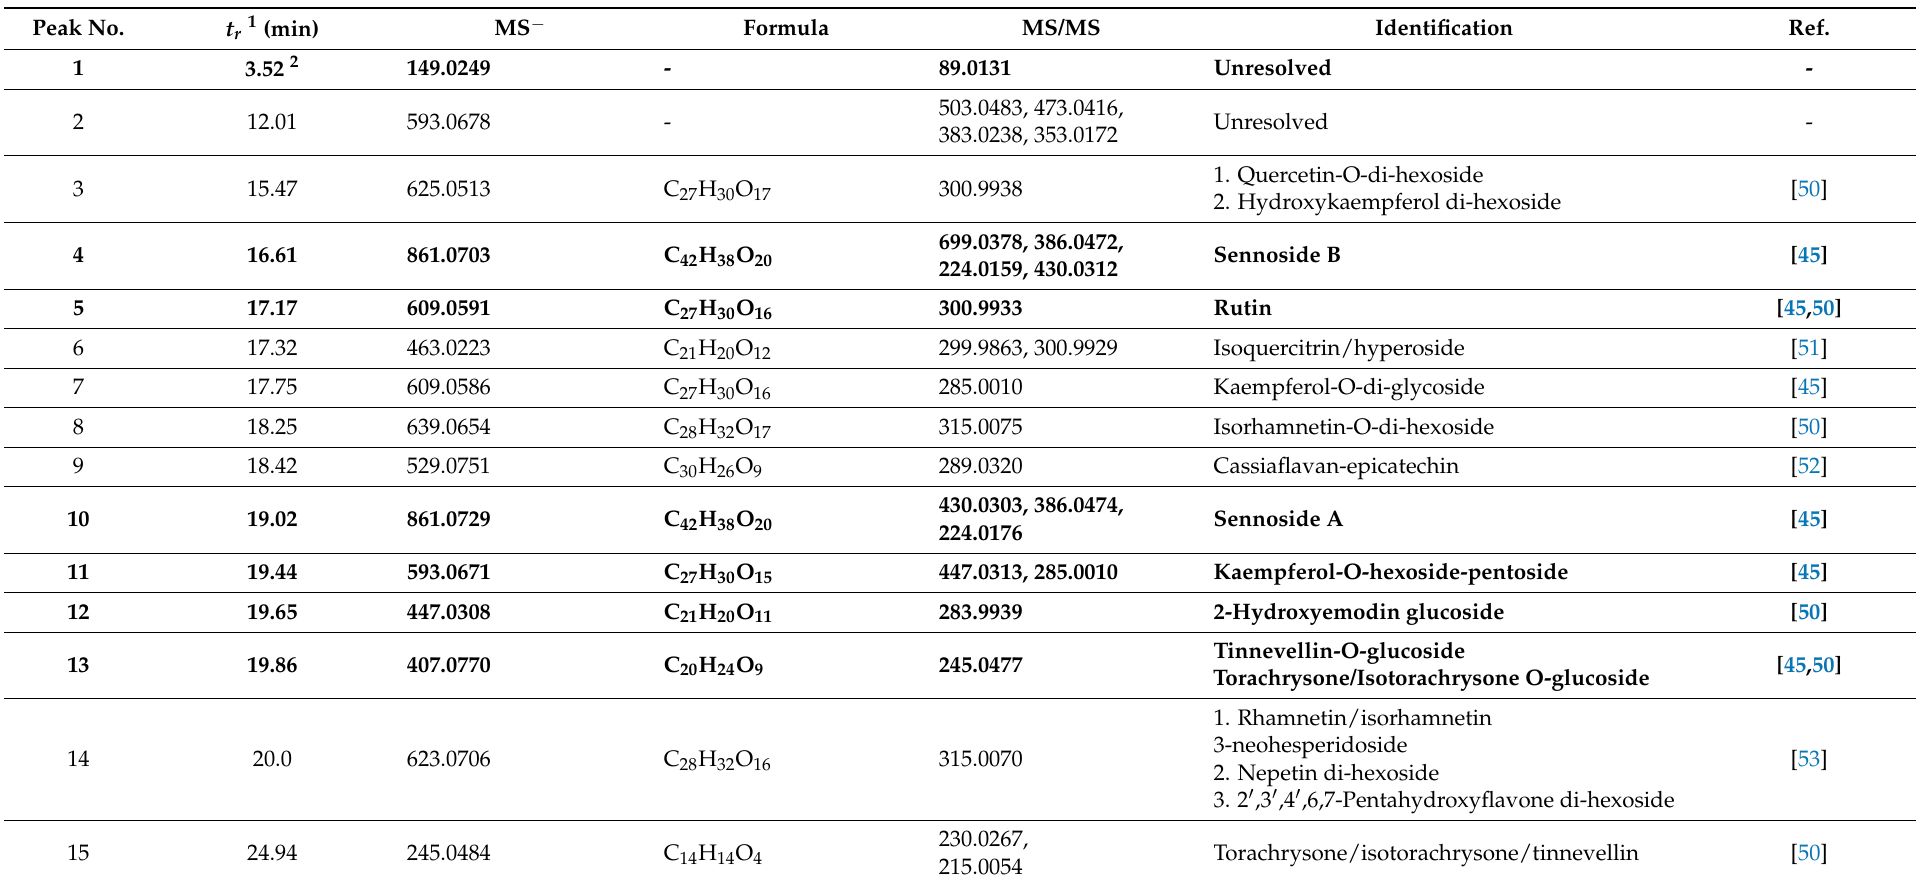
Table 3. Identification of the compounds in the chromatograms of Senna alexandrina (peak number in Figure 7, retention time in the chromatogram, m / z of [M-H] − ion, molecular formula, identity, and reference to mass spectrum used for confirmation of the substance).